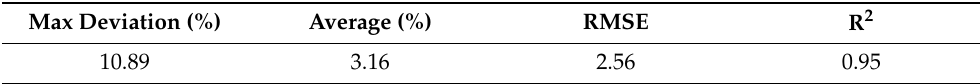
Table 5. Error analysis of the GP